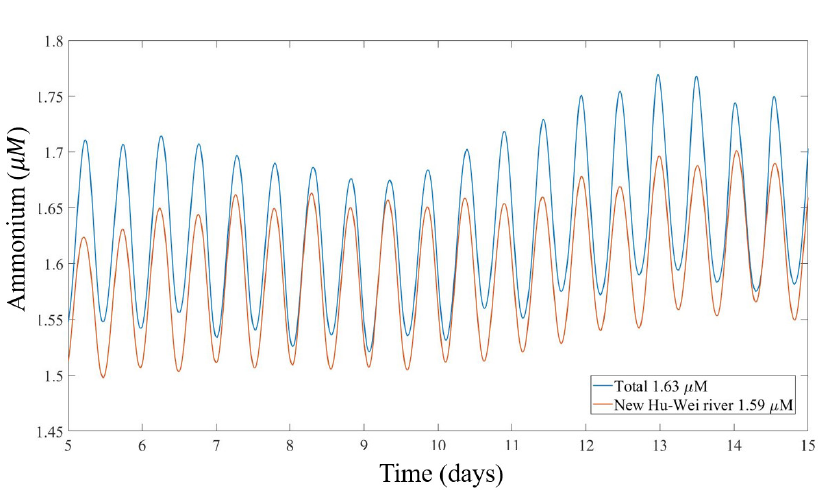
Figure 13. The blue line indicates that the model time series of the total ammonium (1.63 on average) originating from the two river systems varies in the harbor. The red line indicates that the model time series of the NHW ammonium (1.59 on average) only originating from the NHW river varies in the harbor. The two time-series fluctuations from the 3rd to 15th day respond to the flood–ebb and fortnightly spring–neap cycles.